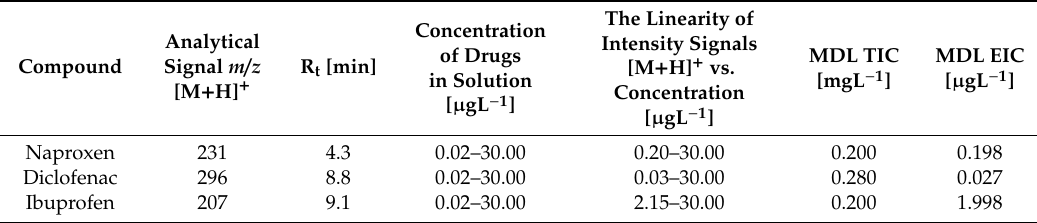
Table 3. Analytical parameters for HPLC-MS in the analysis of drug solutions using AFFINILUTE TM MIP-NSAIDs columns.